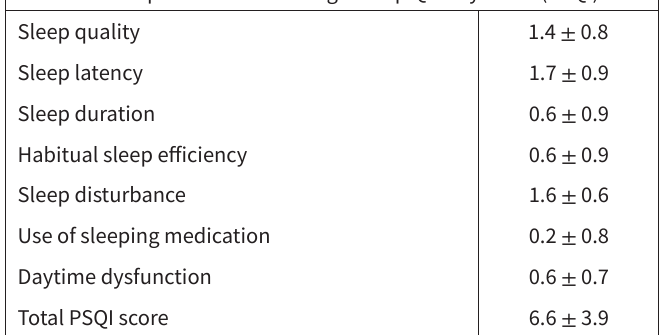
Table 2. Components of Pittsburgh Sleep Quality Index